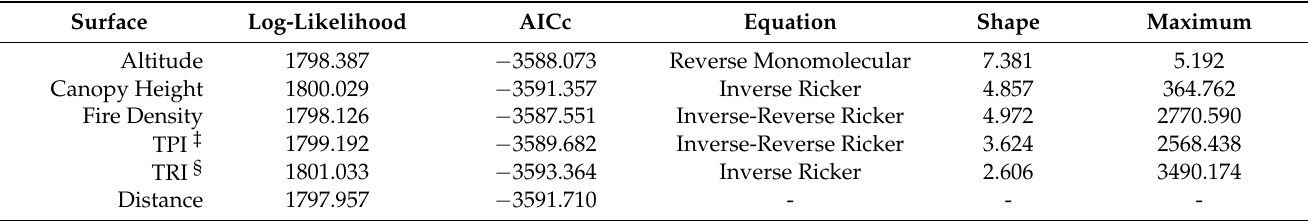
Table 2. Model results and resistance transformation variables, including the transformation equation, shape, and maximum value for the optimized continuous single surface. For each surface, the model was parameterized using log-likelihood, and AICc is presented for corroboration.